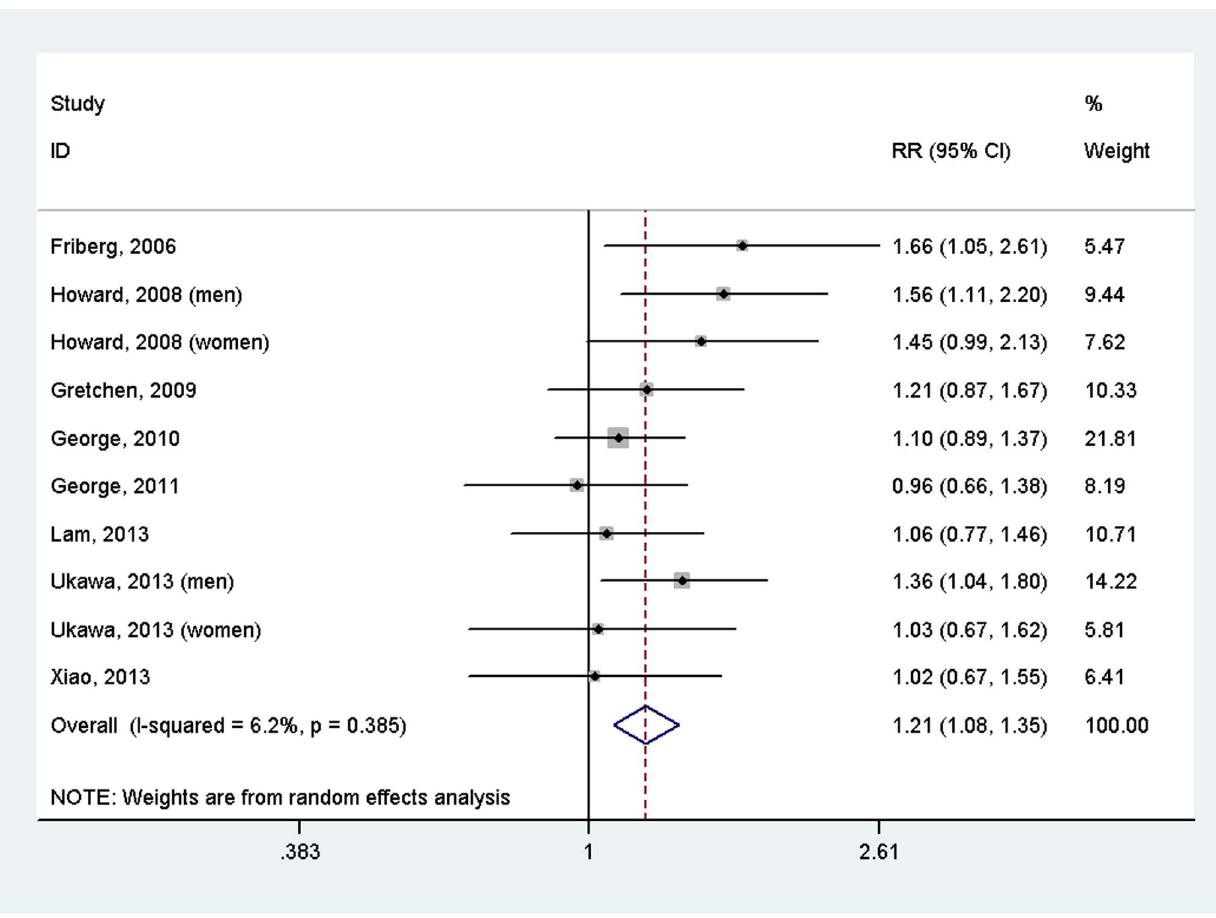
Figure 4. Forest plot of the association between TV viewing and risk of incident cancer (highest versus lowest level).